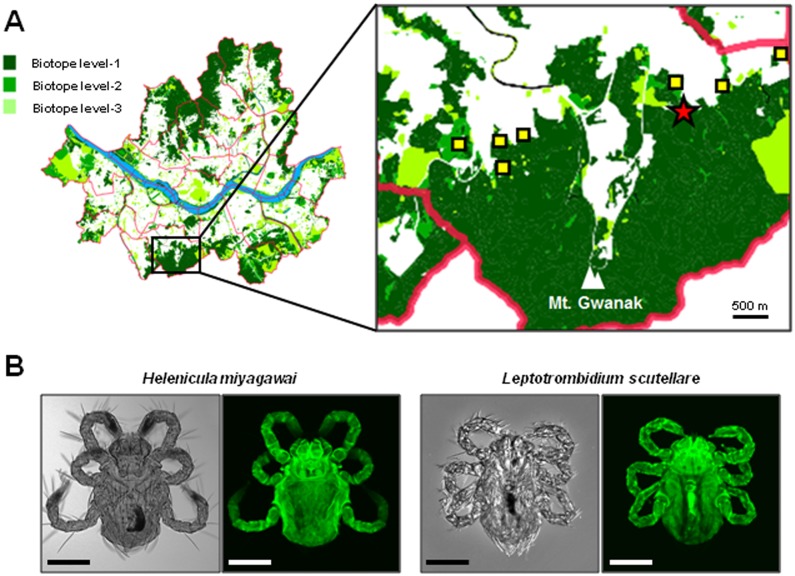
Collection of chigger mites in Mt. Gwanak.(A) Map of scrub typhus infection in the metropolitan city of Seoul from 2010 to 2013. Among 1,110 patients interviewed, 88 cases were suspected to occur during outdoor activity within Seoul. Eight potential sites of infection (quadrangle and star) identified in 2012 from nine cases and the location of chigger mite collection (star) on the foot of Mt. Gwanak are presented in the right panel. The district map of Seoul was obtained from public SGIS services of Statistics Korea (http://sgis.kostat.go.kr). (B) Representative microscopic images of Helenicula miyagawai and Leptotrombidium scutellare collected in this study. Differential interference contrast (DIC) images (left panels) and autofluorescent images (right panels) of the chigger mite were taken using light microscopy and confocal laser scanning microscopy, respectively. Bar: 100 μm.